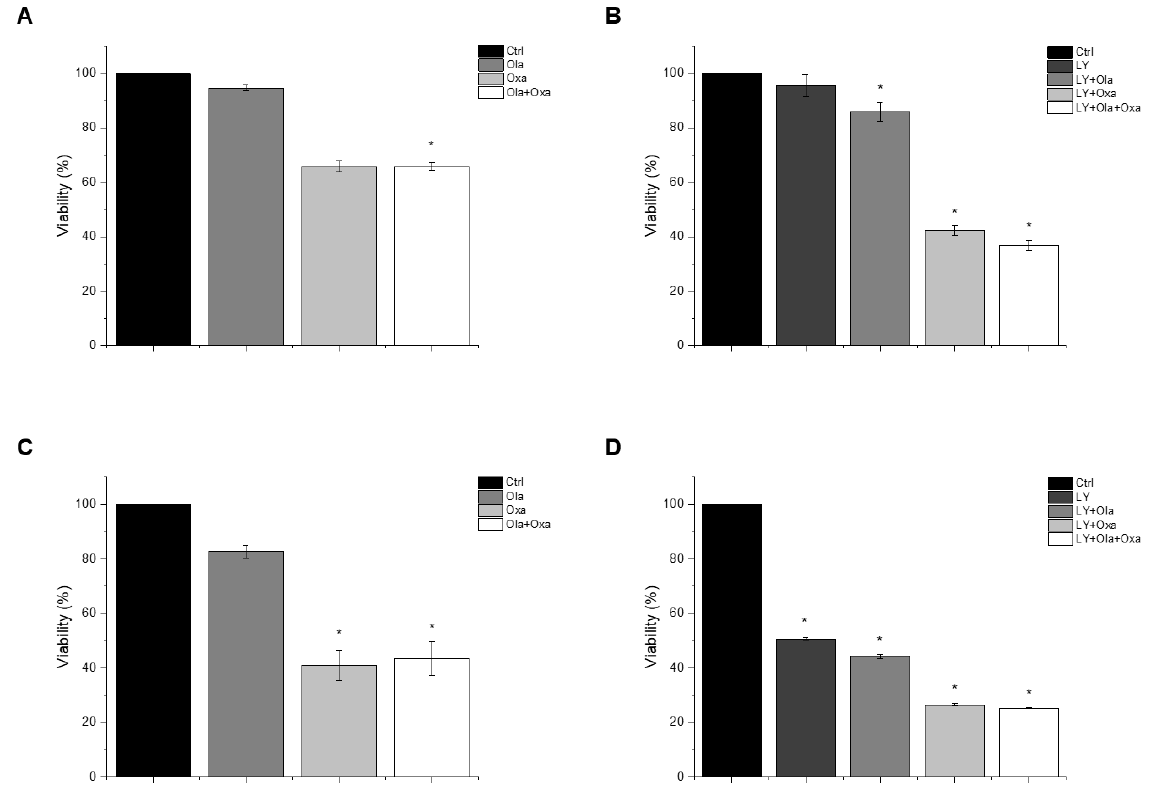
Figure 1. The effects of Ola, Oxa and LY on the viability of TNBC MDA-MB-231 ( A , B ) and non-TNBC MCF7 ( C , D ) cells were evaluated by MTT assay. Cells were treated with 2 µM olaparib, 25 µM oxaliplatin, 1 µM LY294002 alone and in combination for 72 h. Data are shown as mean ± SEM of at least three separate experiments. * p < 0.05 compared with the untreated cells. Ola—olaparib; Oxa—oxaliplatin; LY—LY294002; TNBC—triple-negative breast cancer; MTT-3-(4,5-dime-